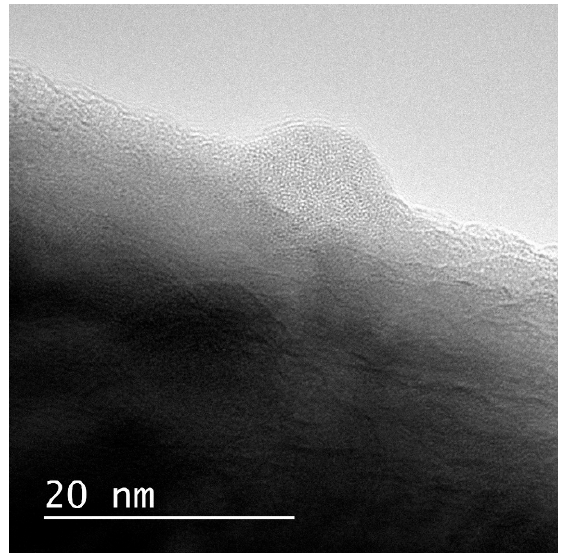
Figure 6. Bright field images of hillocks induced in SrTiO 3 irradiated with 200 MeV Au 32+ at an oblique incidence angle.